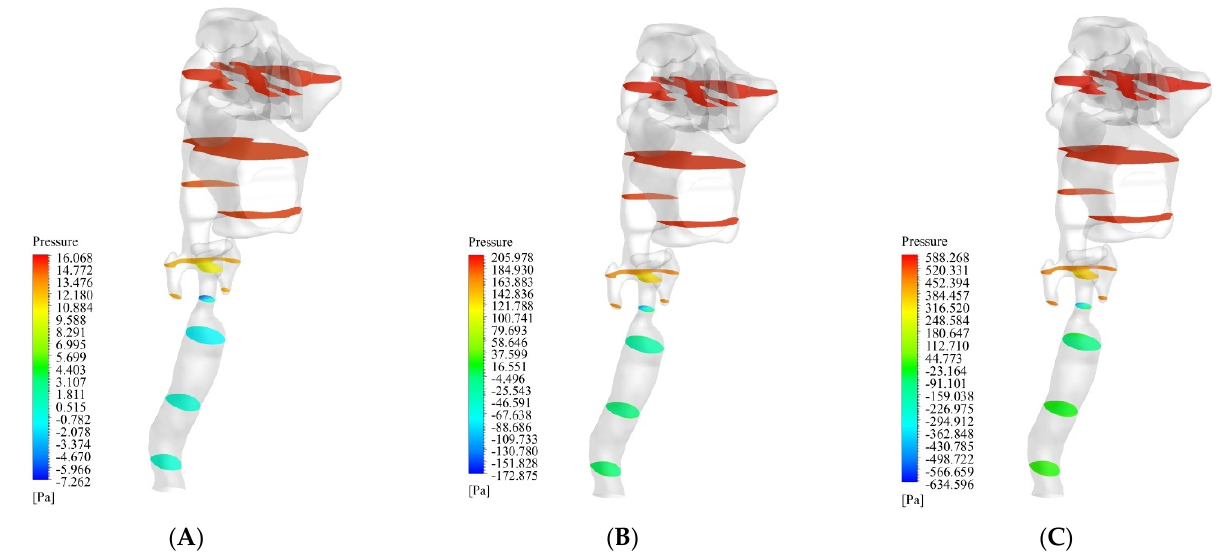
Figure 8. Cross-sectional pressure distribution of the airflow at three flow rates of 13 L/min, 55 L/min, and 100 L/min. ( A ) 13 L/min. ( B ) 55 L/min. ( C ) 100